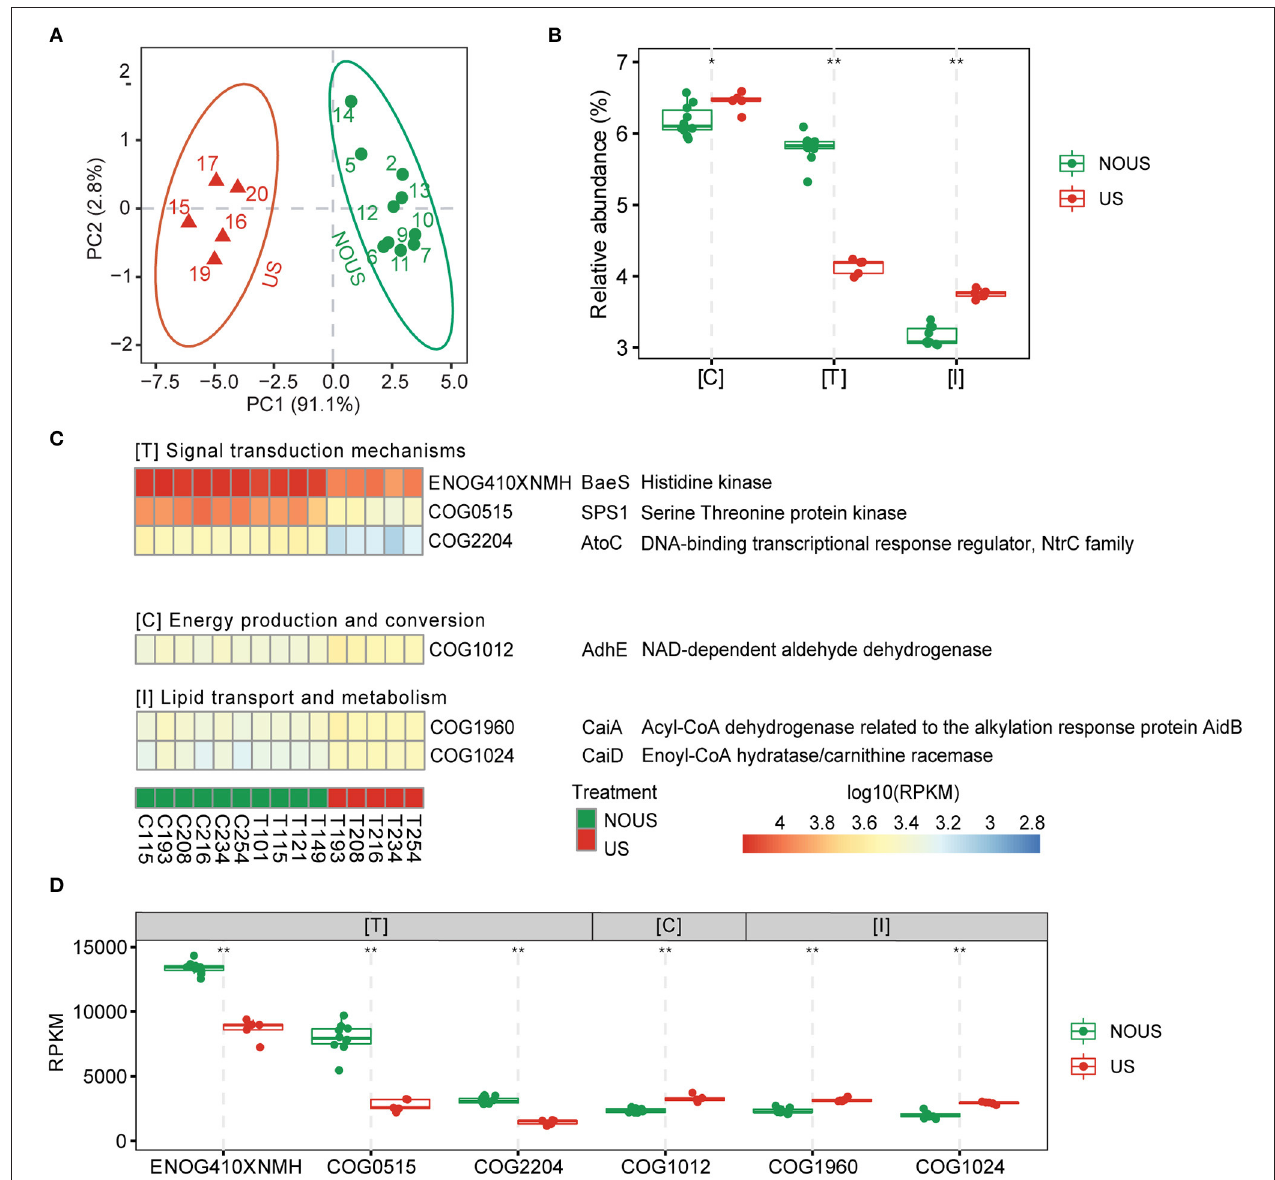
FIGURE 3 | Functional differences driven by ultrasonic treatment. (A) Principle component analysis (PCA) of orthologous group abundances matrix, which showed a similar cluster with the phylogenetic profile. Samples were clustered into ultrasonic treatment (US) and without ultrasonic treatment (NOUS) groups. (B) Comparison of the ortholog group (COG) function categories whose abundance significantly changed. The most affected functions of all microorganisms when exposed to ultrasound based on Linear Discriminant Analysis (LDA) of the ortholog groups (COG) annotated functions that were significantly enriched in respective groups ( p < 0.05, |LDA| > 3.5). (C) Heatmap of the COGs that contributed to principal components of the community. The abundance of ortholog groups in each sample was scaled to log10 of reads per kilobase per million mapped reads (RPKM) for the color scale of the heatmap. (D) Comparison of NOG using Wilcoxon test. (* p < 0.05; ** p <